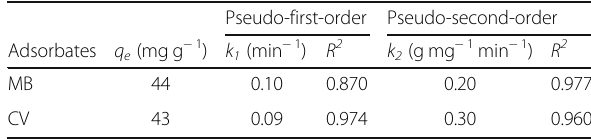
Table 1 Kinetic parameters for the adsorption of CV and MB dyes on ASS adsorbent (adsorbent dose of 50 mg, volume of adsorbate of 20 mL, pH of 8, and temperature of 27